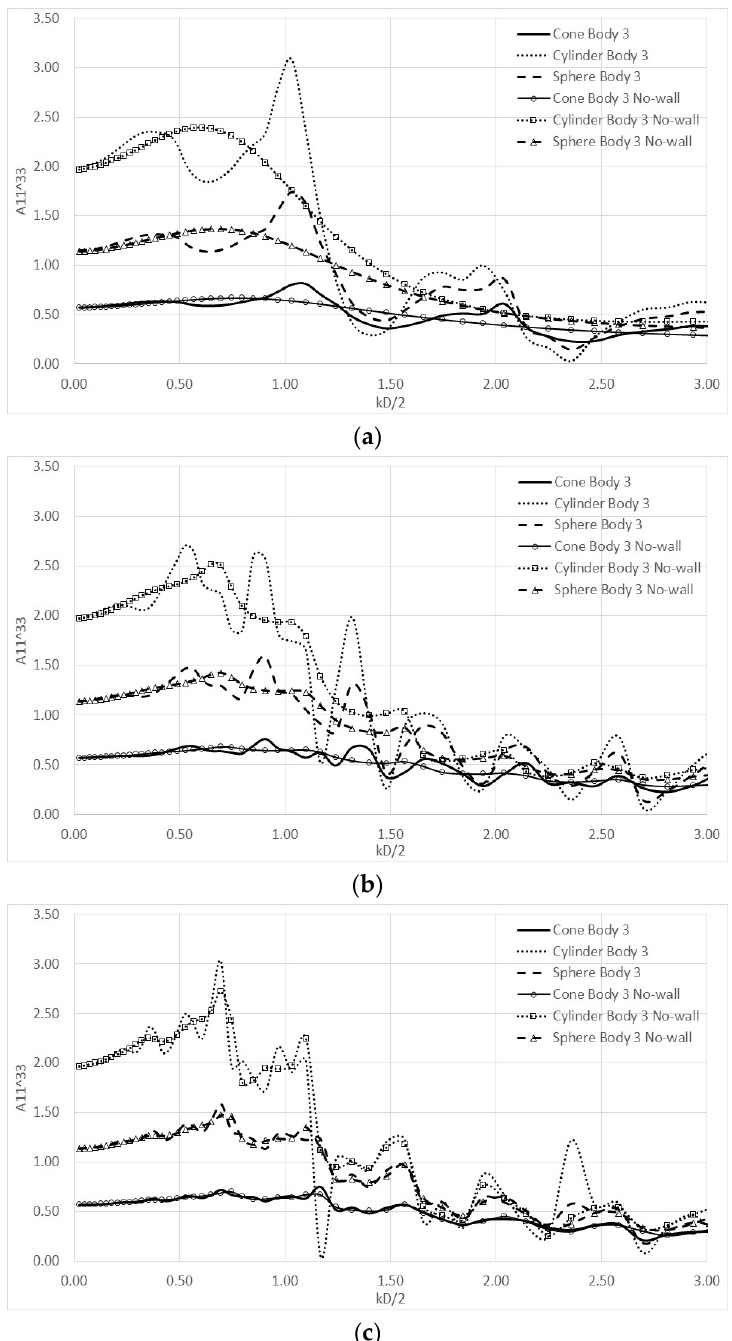
Figure 13. Dimensionless added mass of the 3rd floater at the surge direction due to its motion at surge against kD / 2, for the three di ff erent examined array configurations. Comparison with the corresponding added mass on the same floater of the arrays without the presence of the breakwater: ( a ) parallel arrangement, C 1 ; ( b ) rectangular arrangement, C 2 ; ( c ) perpendicular arrangement, C 3